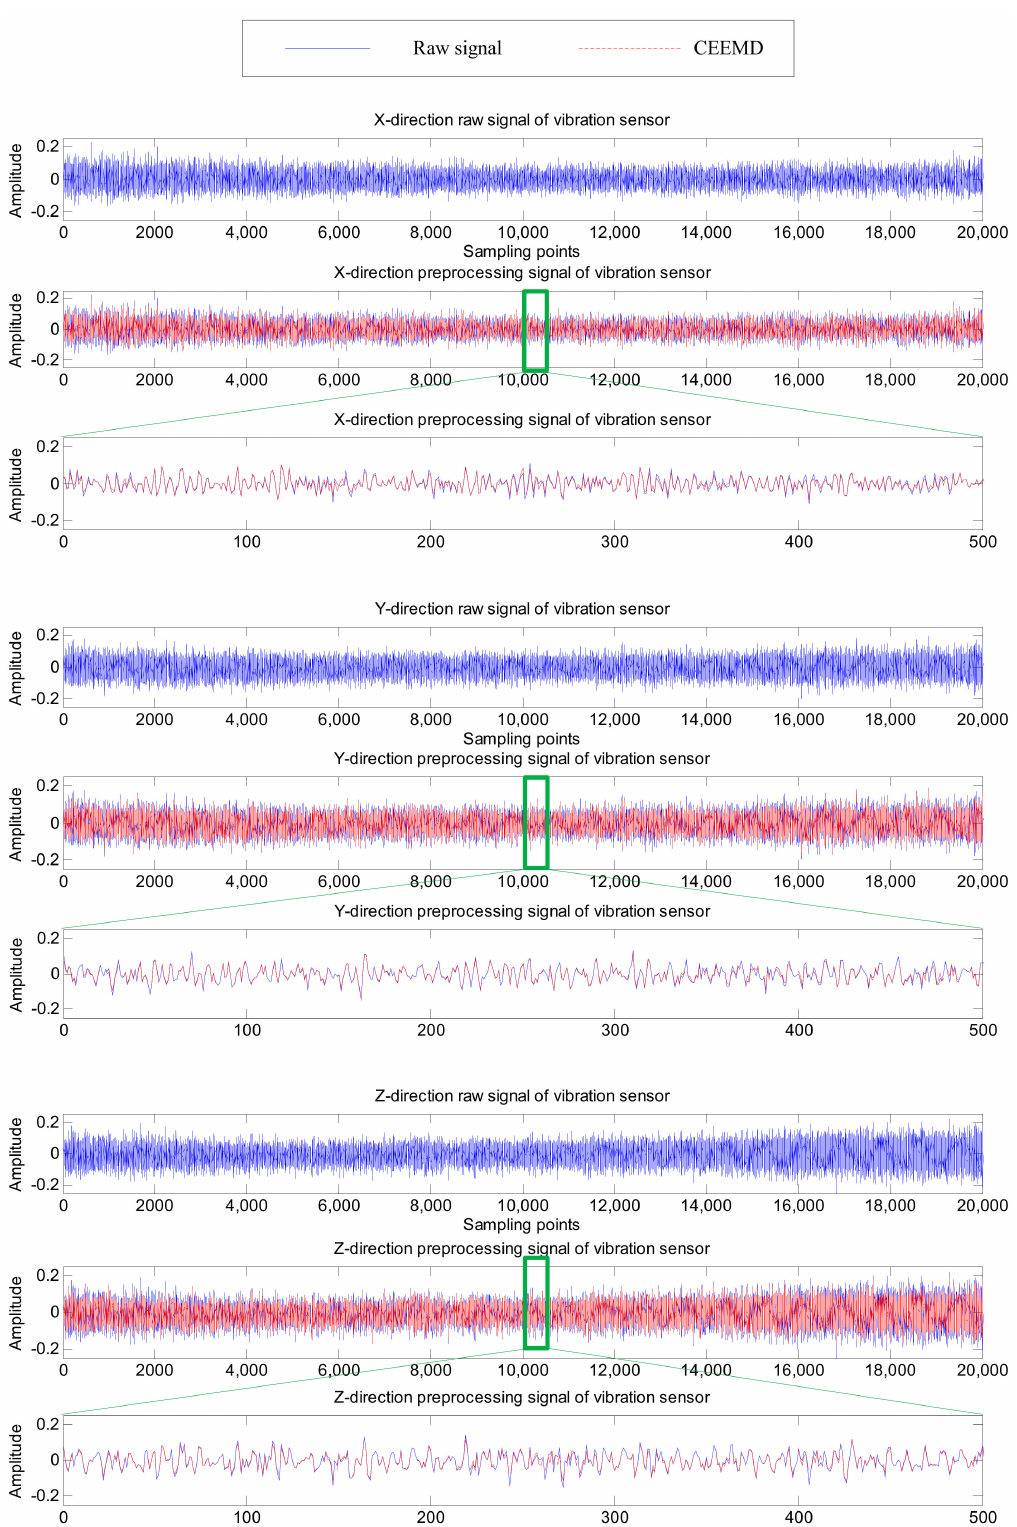
Figure 8. The raw and preprocessed signals of vibration sensor in one